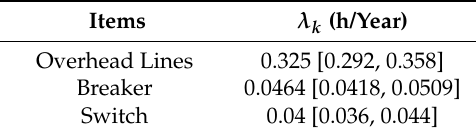
Figure 5. Voltage profiles of IEEE 33-bus system. Table 1. Reliability data of related equipment (with interval data).